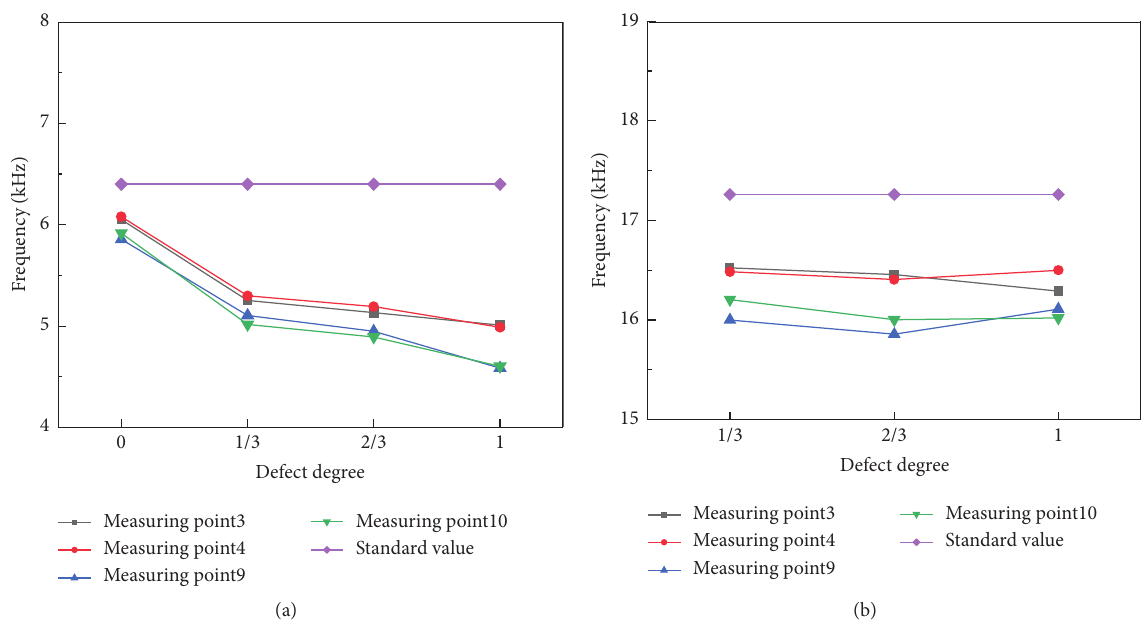
Figure 6: Frequency diagram of measuring points on the plate 1# (a) Plate thickness frequency chart (b) Defect frequency chart. Table 4: Measurement point results of plate No. 2.